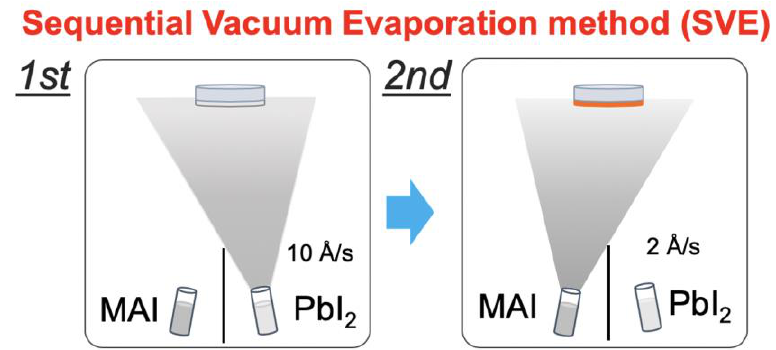
Figure 1. The schematic of the sequential vacuum evaporation (SVE) method.